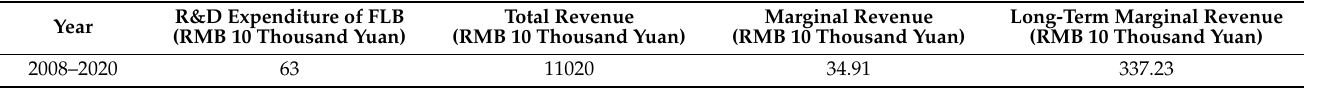
Table 5. Revenue of R&D expenditure of FLB during